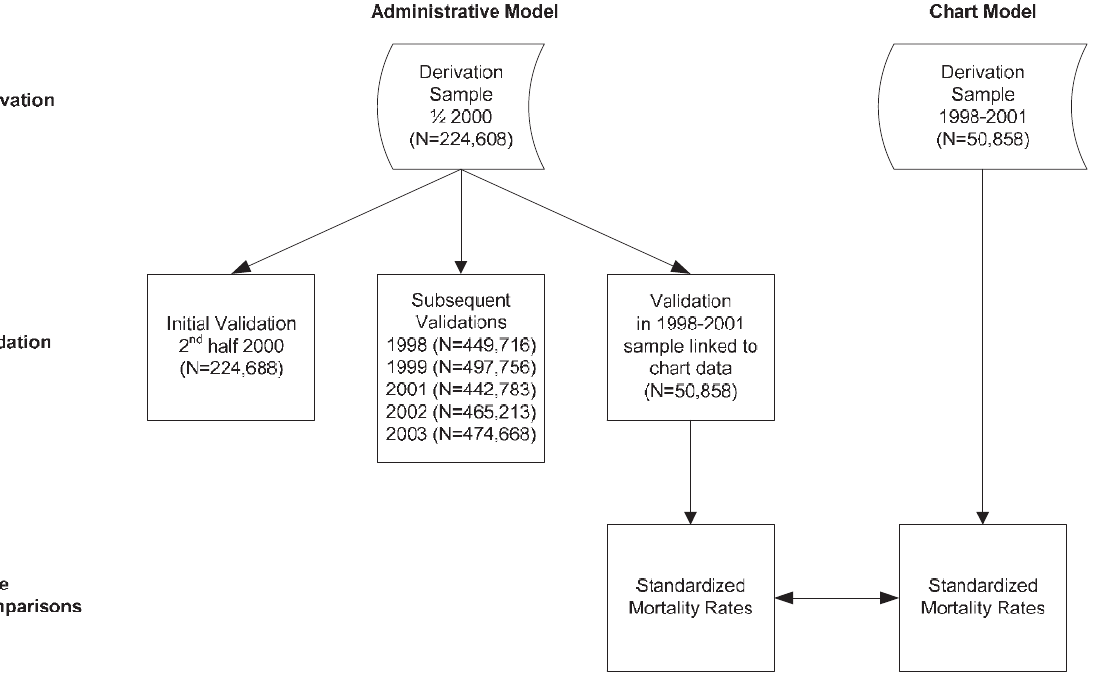
Figure 1. Development of the derivation and validation cohorts for the pneumonia mortality models. The administrative derivation cohort included a stratified random sample of half of the eligible pneumonia discharges for calendar year 2000. Subsequent administrative validation cohorts included the other half of eligible discharges from 2000, and all eligible discharges for calendar years 1998, 1999, and 2001–2003. The chart model derivation cohort included 50,858 eligible patients with abstracted medical record data. An additional administrative validation cohort using the claims of patients in the chart model derivation cohort was created to compare state-specific standardized mortality rates generated by the 2 models.